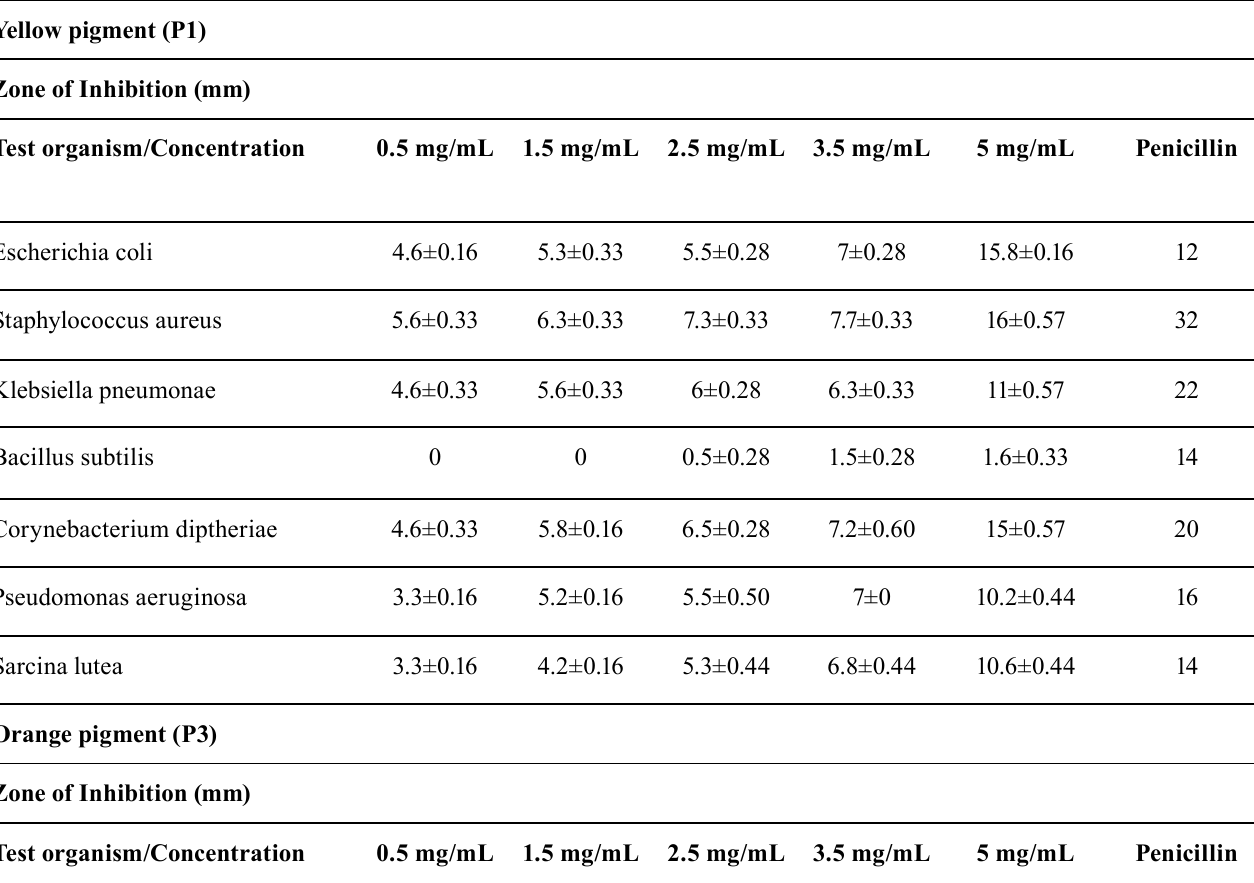
TABLE V – A ntibacterial activity of methanolic extracts (0.5-5 mg/mL) of pigments. Diameter of zone of inhibition (ZOI)